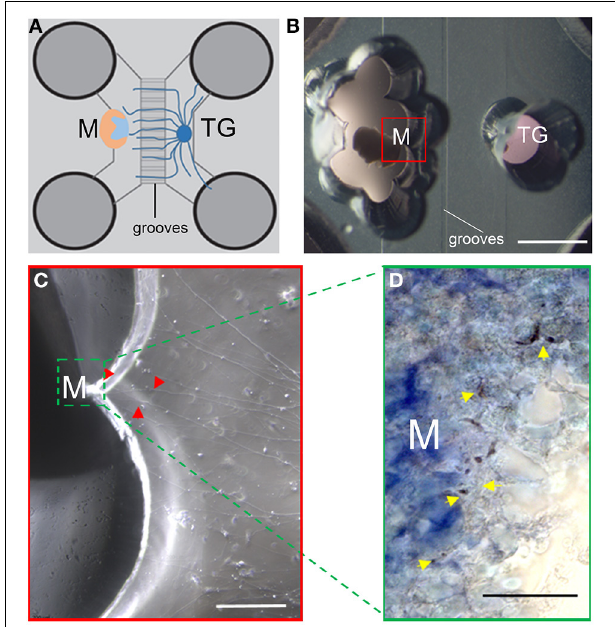
FIGURE 5 | Co-culture of trigeminal ganglia (TG) and postnatal molars. (A) Schematic representation showing the disposition of E15.5 TG and postnatal molars in the microfluidics chamber. The molar is oriented with the pulp facing the ganglion. (B) PN5 molar (on the left) and E15.5 TG after 10 days of culture. Red box: magnification in panel (C) . (C) Neurites (red arrowheads) grow toward the tooth germ (green line) and penetrate into the tooth germ. (D) Section of the cultured tooth germ. Neurofilament staining shows that neurites have contacted the dental pulp (yellow arrowheads). Scale bars: 2mm for (B) , 200 μ m for (C) , and 20 μ m for (D) . Abbreviations: TG, trigeminal ganglion; M,